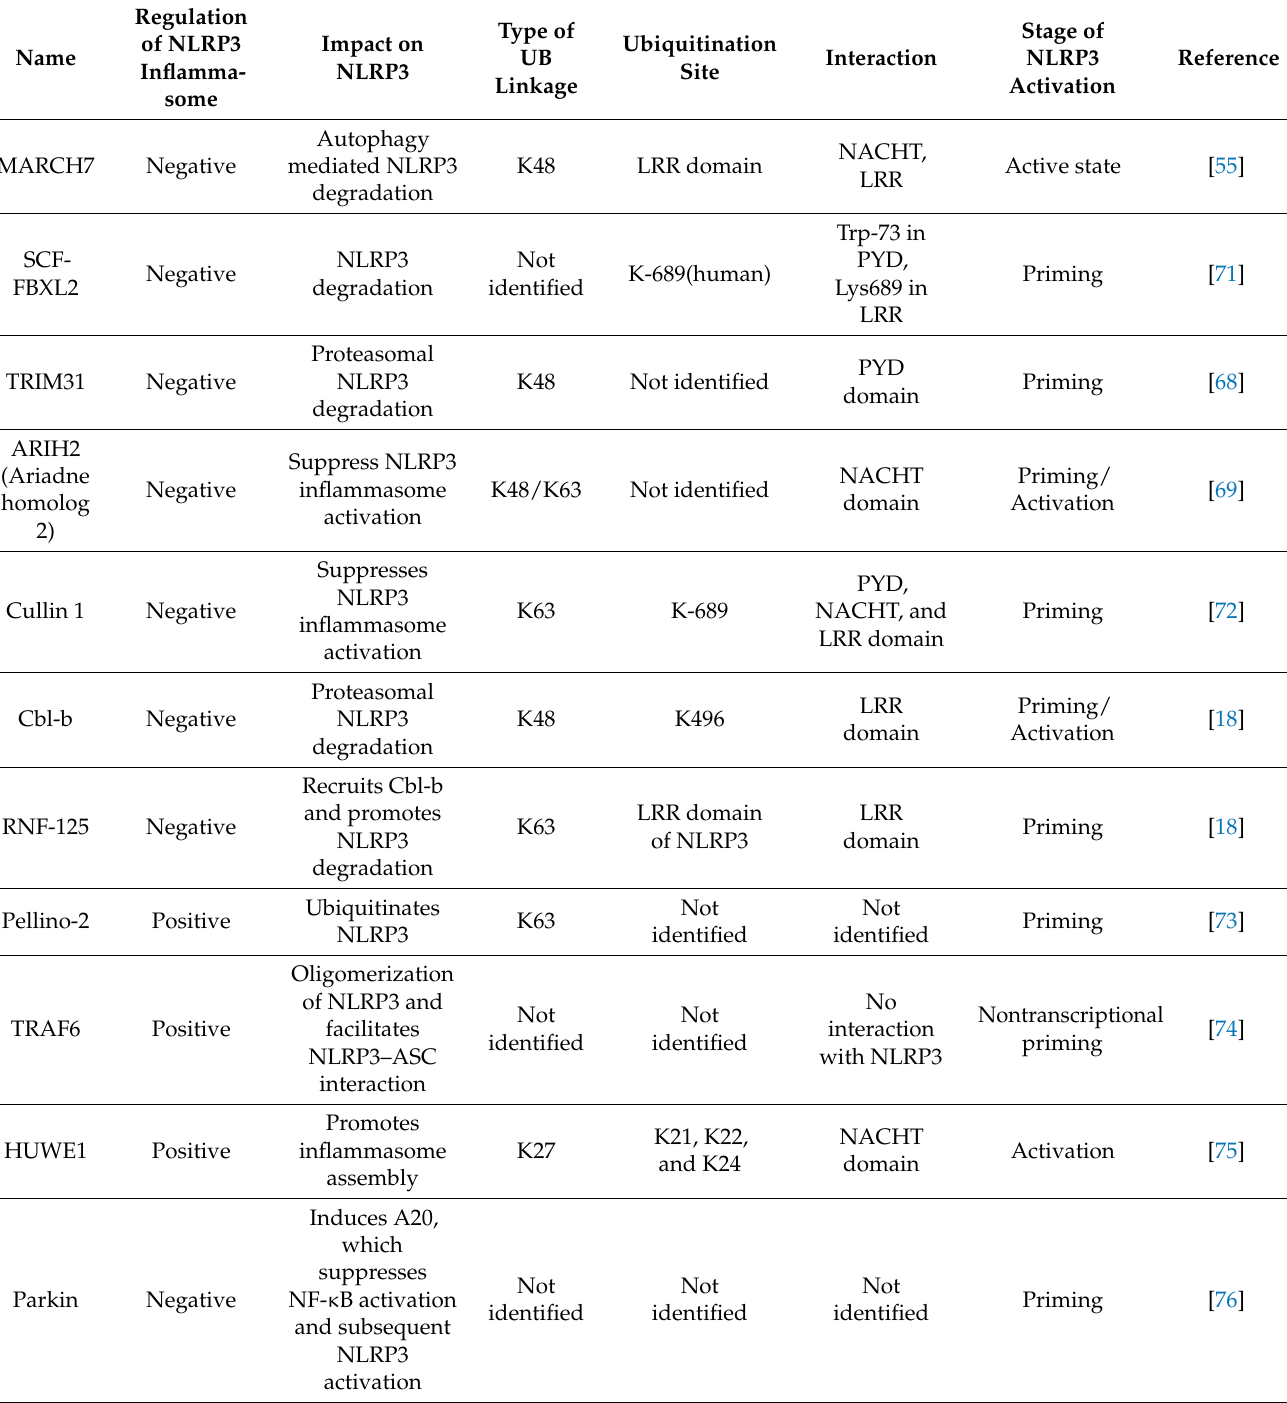
Table 1. Regulation of NLRP3 by E3